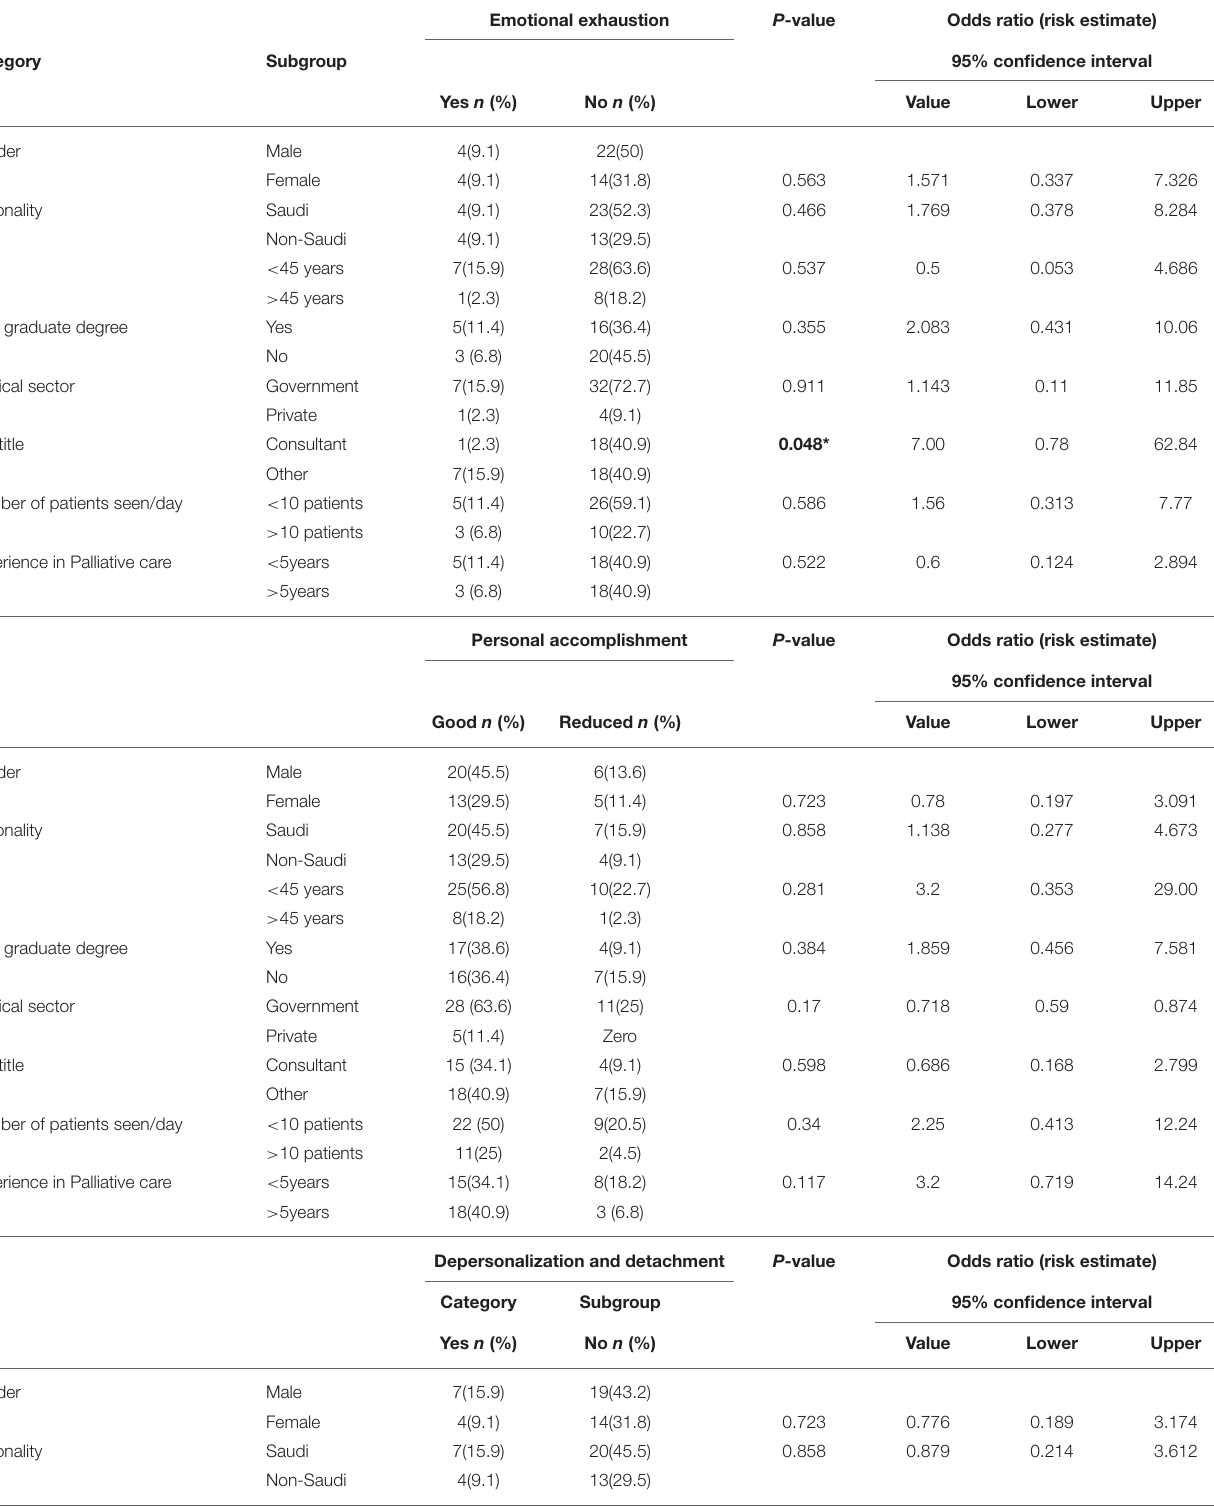
TABLE 5 | Factors affecting burnout among palliative care clinicians in Saudi